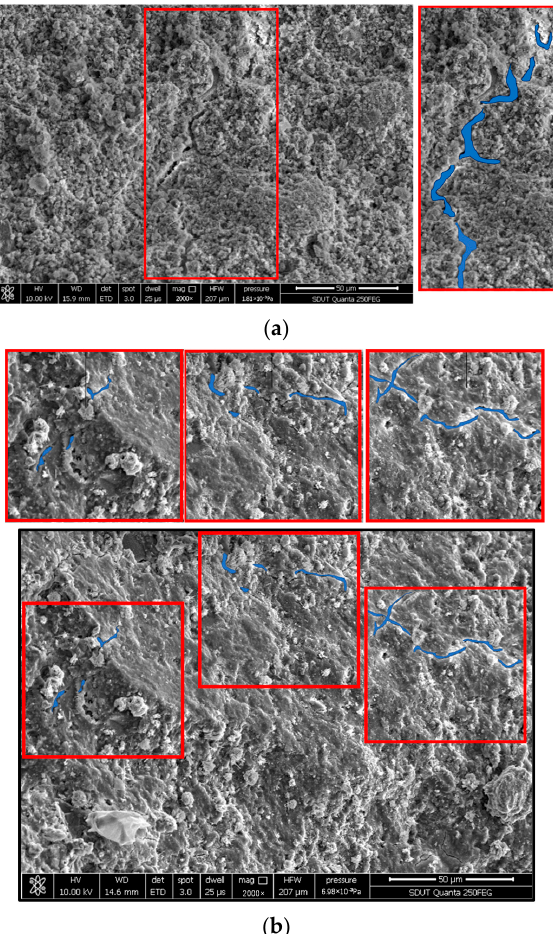
Figure 8. The SEM diagram of toughening mechanism on rubber powder: ( a ) NAC; ( b ) CSAC.